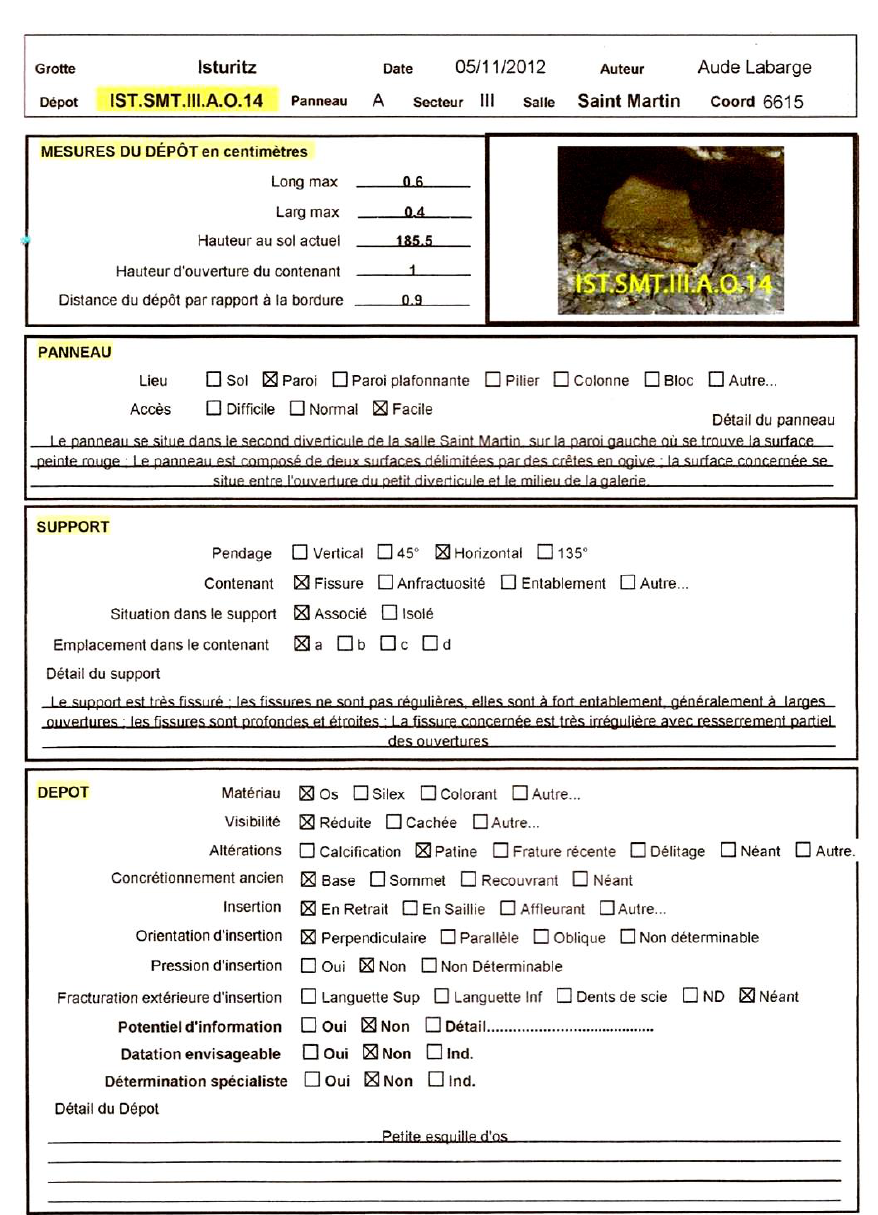
Table 1. Example of a deposit recording sheet, Isturitz